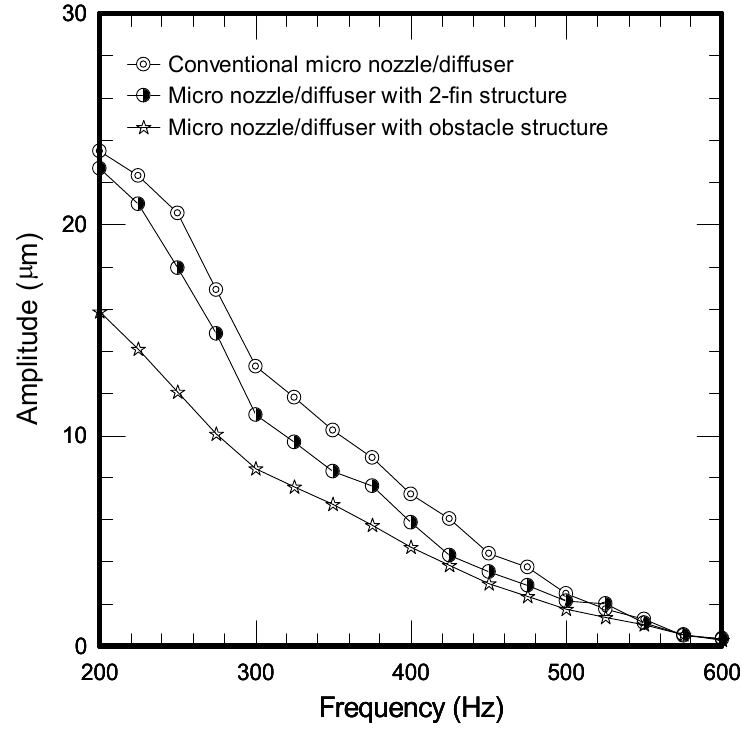
Figure 3. Frequency vs . amplitude for tested micropumps.